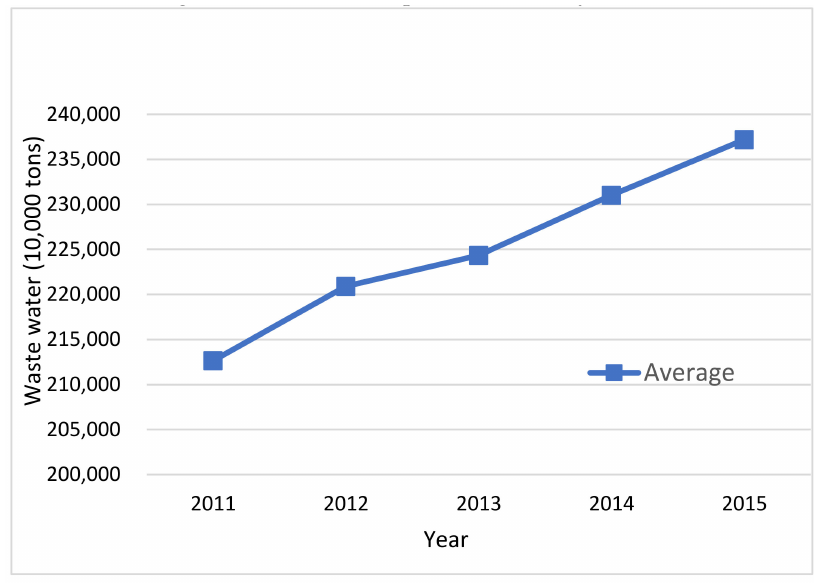
Figure 5. Average discharged wastewater over 2011–2015 in China.